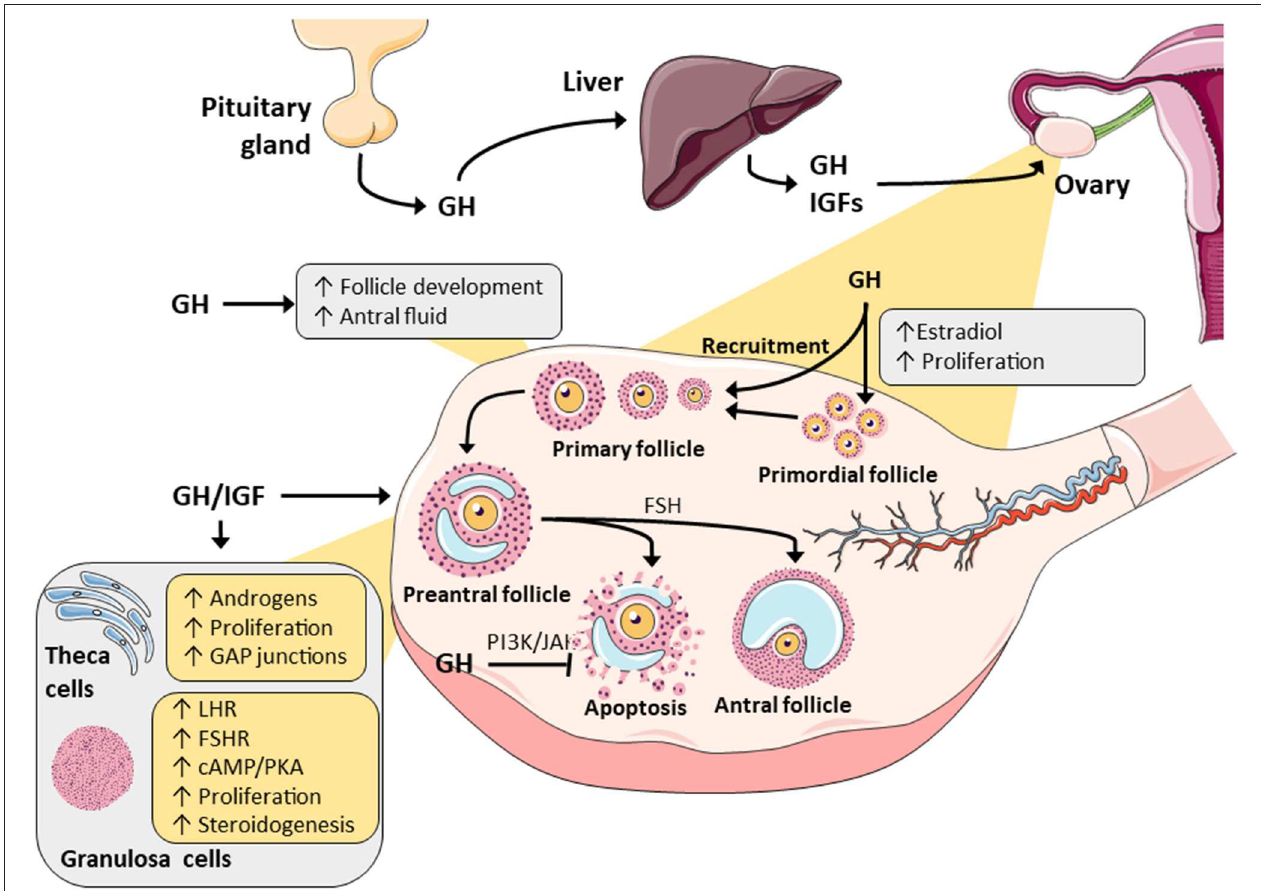
FIGURE 1 | A summary of the major actions of GH and IGF in ovarian physiology. Both have been demonstrated to promote steroidogenesis in granulosa and theca cells through alterations in metabolizing enzymes. GH/IGF have also been reported to synergistically work with gonadotropins to alter steroidogenesis and this is possibly mediated by changes in the gonadotropic receptors. Finally, through intracellular signaling pathways (JAK/STAT and PI3/AK), GH and IGF may promote follicle selection and survival by decreasing follicular